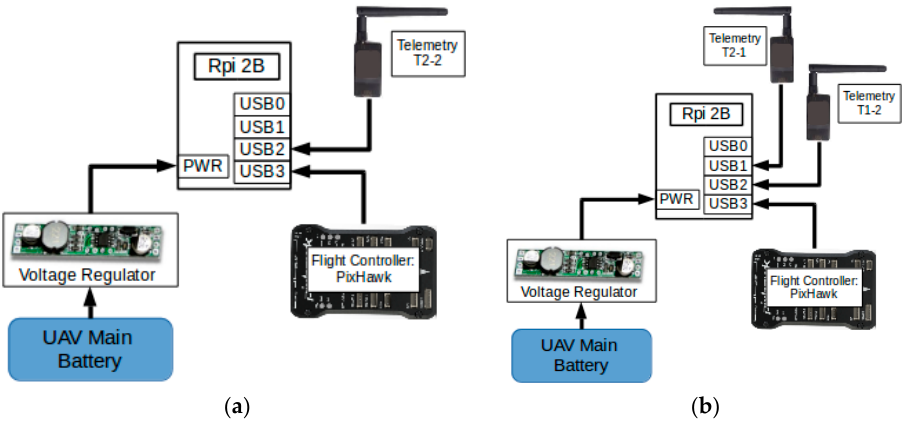
Figure 9. Hardware connection diagram of ( a ) UAV “Son” and ( b ) UAV “Mom”.